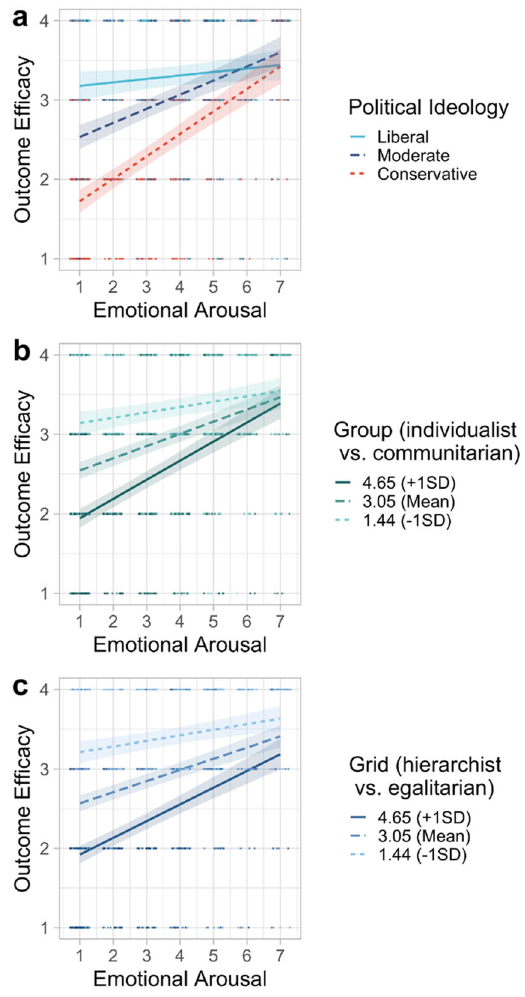
Fig. 2 Interaction effects between risk perception and emotional arousal across groups of